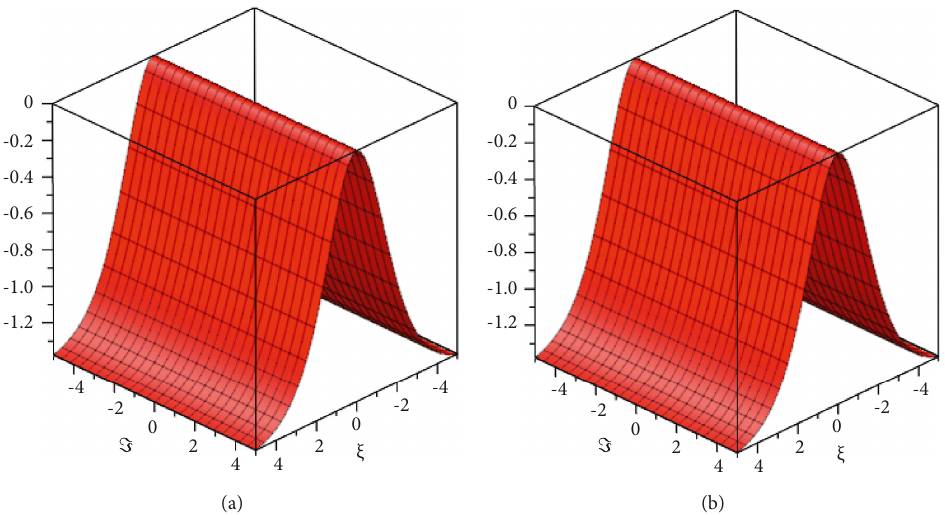
Figure 2: Exact solution and analytical solution for ] ( ξ , I ) problem